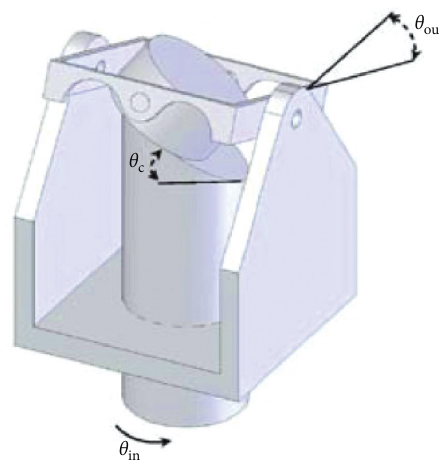
Figure 2: The gimbal drive [11].